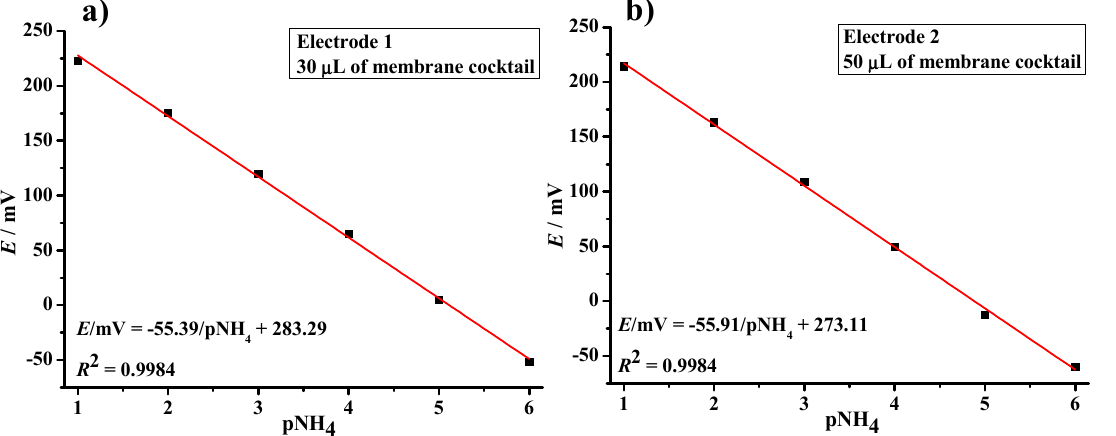
Figure 2. Response of the graphite electrode coated with mixture of ammonium selective membrane; volumes of 30 µL ( a ) and 50 µL ( b ), respectively.